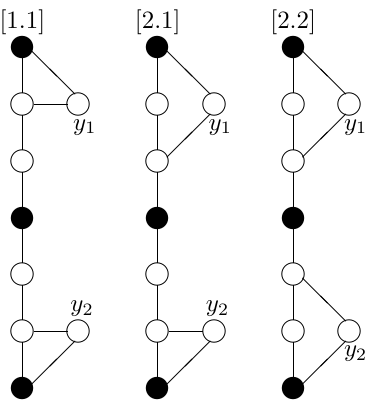
Fig. 18: Fixing v 7 for a maximum backbone tree of type 1 in case [1] or case [2] .